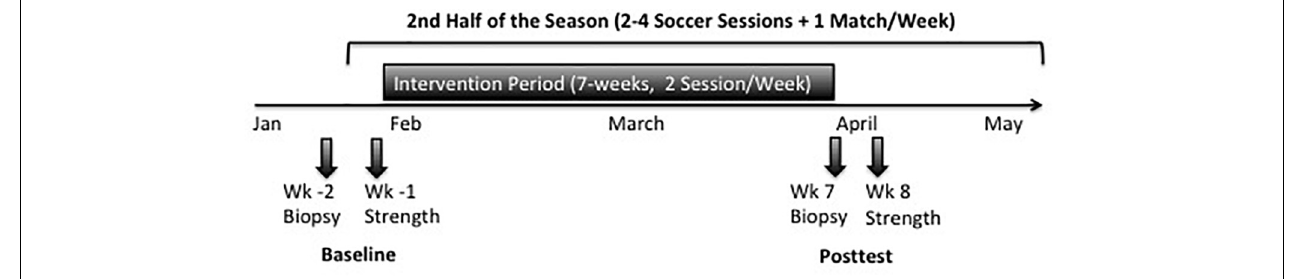
FIGURE 1 | Timeline of strength testing and muscle biopsies during the study in the second half of the season.